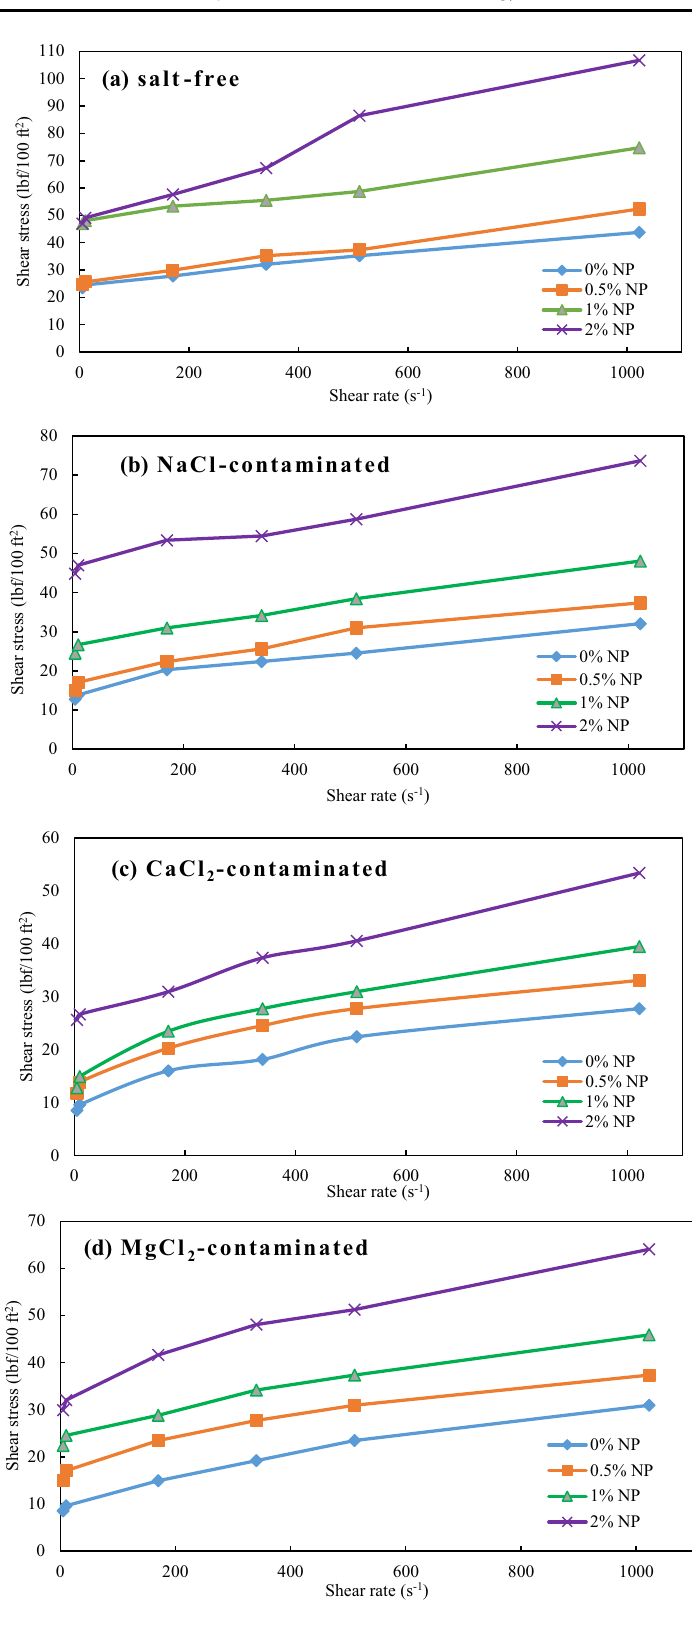
Fig. 1 Rheological behavior of: a salt-free drilling